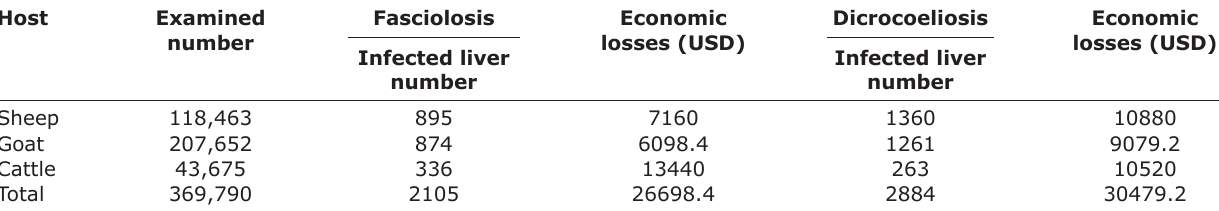
Table-3: The annual financial loss resulting from Fasciola hepatica , Fasciola gigantica , and Dicrocoelium dendriticum in slaughtered animals.